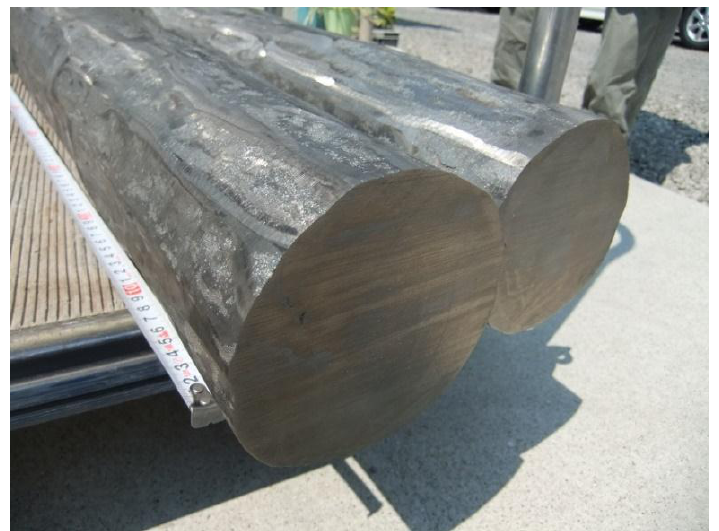
Figure 2. Photograph of the forged ingot that is approximately 100 mm in diameter, which was mechanically thinned from the VAR-fabricated TiZr ingot that was 240 mm in